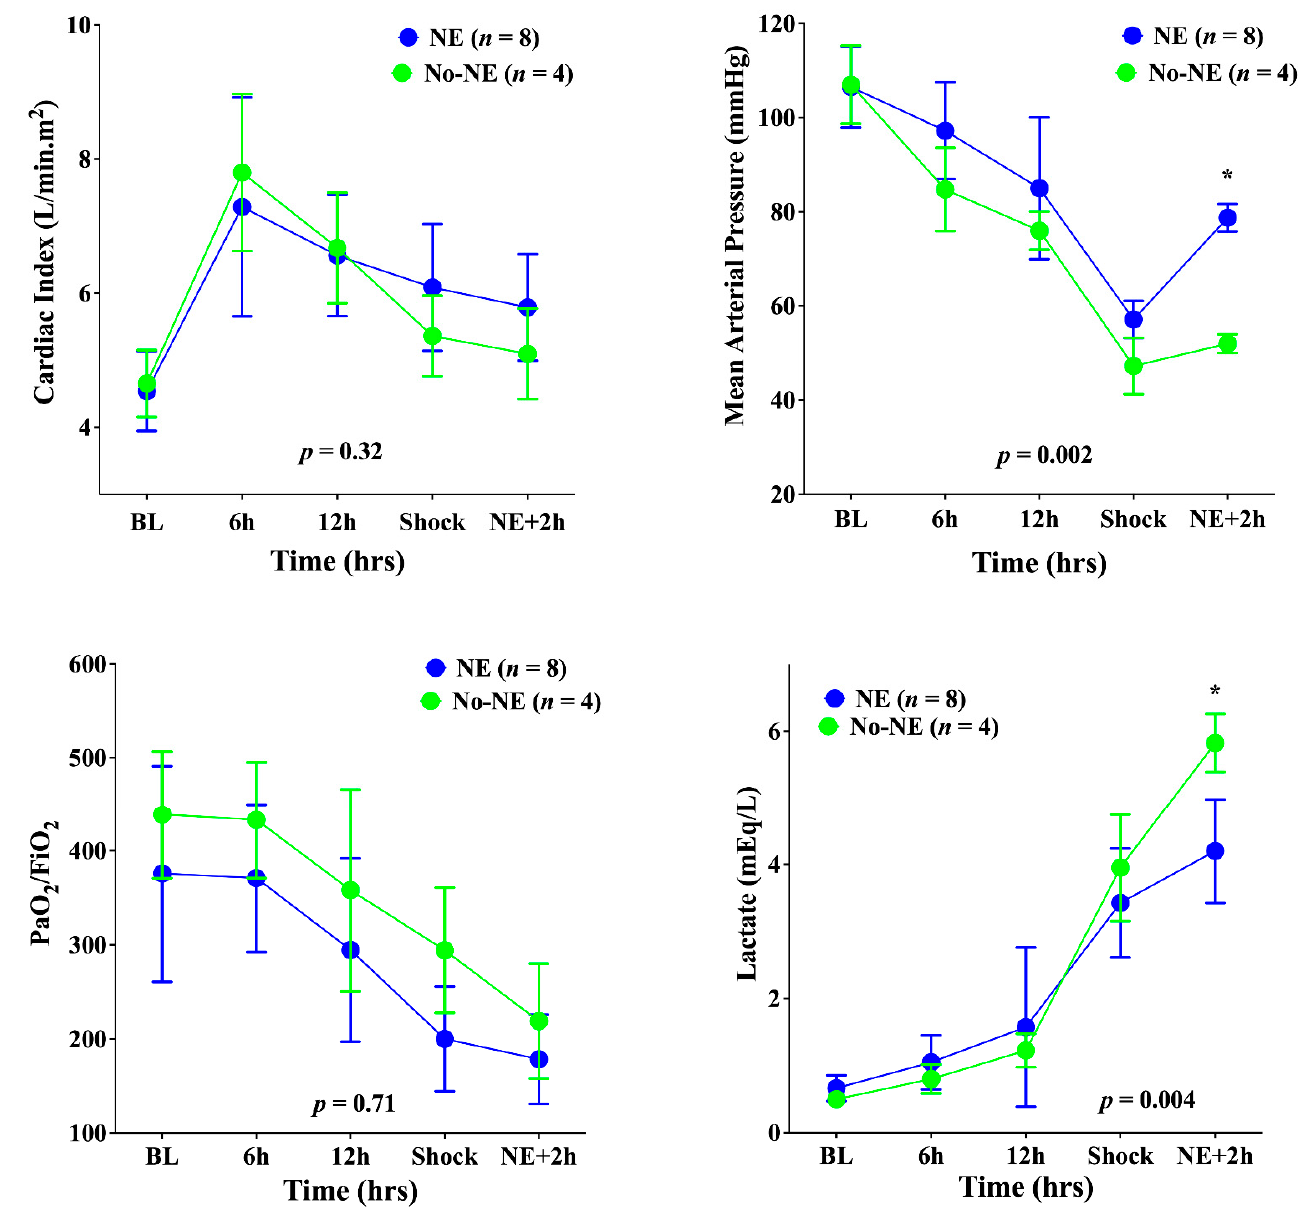
Figure 1. Cardiac output, mean arterial pressure, the PaO 2 /FiO 2 ratio, and lactate levels in the two groups at different study time-points. NE, norepinephrine. Data are presented as mean ± SEM. * p < 0.05 from Sidak post hoc analysis.